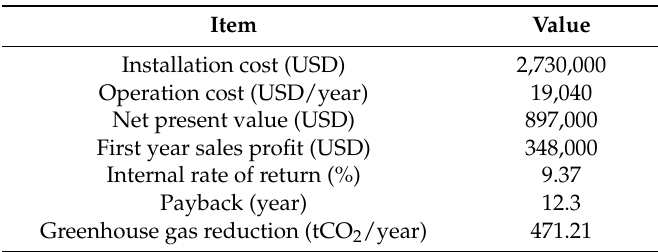
Table 7. Results of economic and greenhouse gas reduction analyses for the floating photovoltaic system in the study site. Item